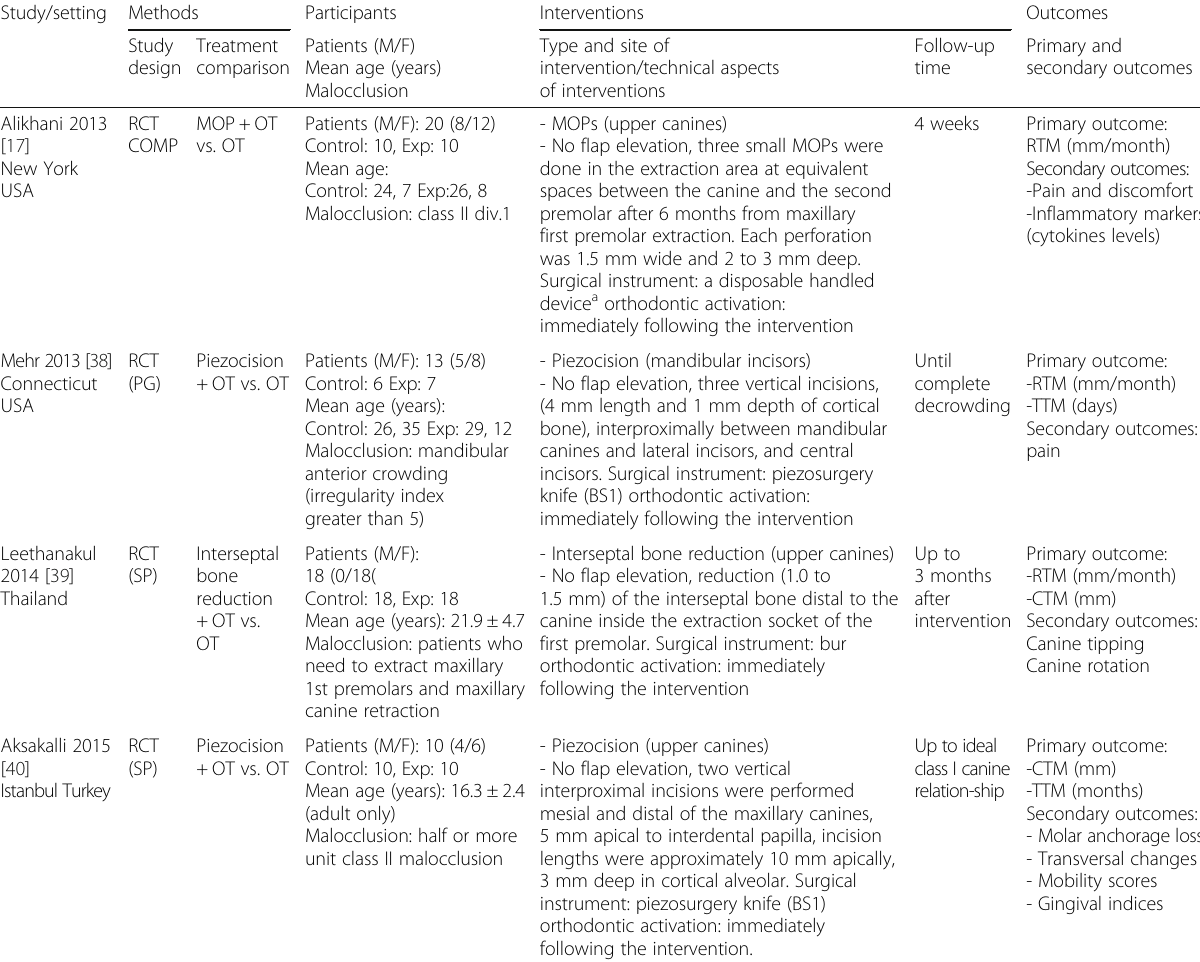
Table 1 Characteristics of included studies in the systematic review Study/setting